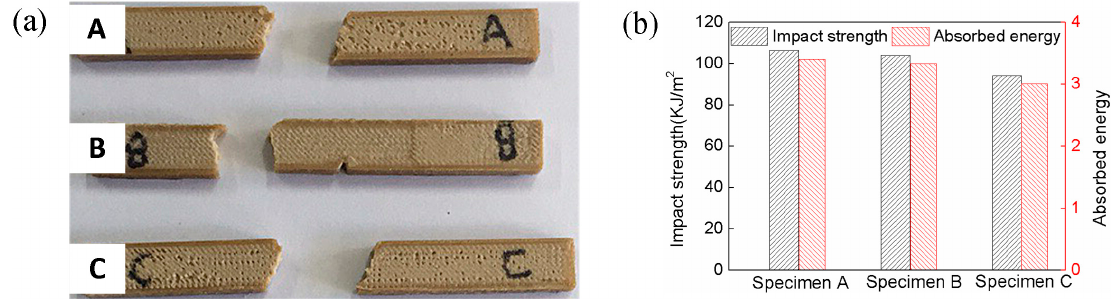
Figure 8. Impact test of PEEK FDM specimens . ( a ) Fractured impact specimens; ( b ) Impact strength and absorbed energy.